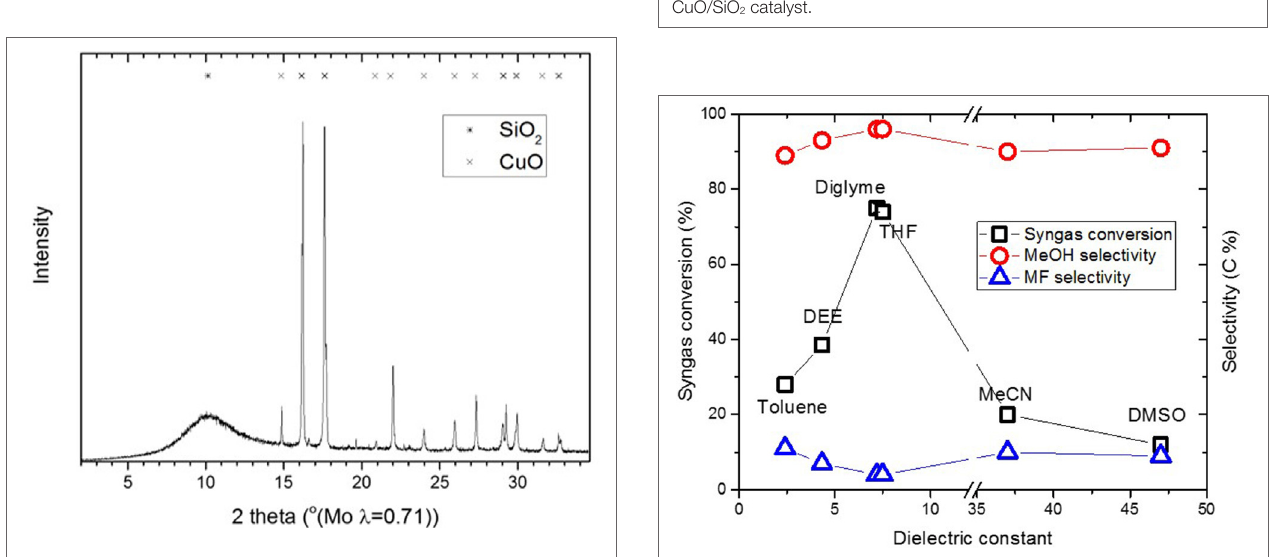
FigUre 8 | X-ray diffractogram of calcined CuO/SiO 2 catalyst.